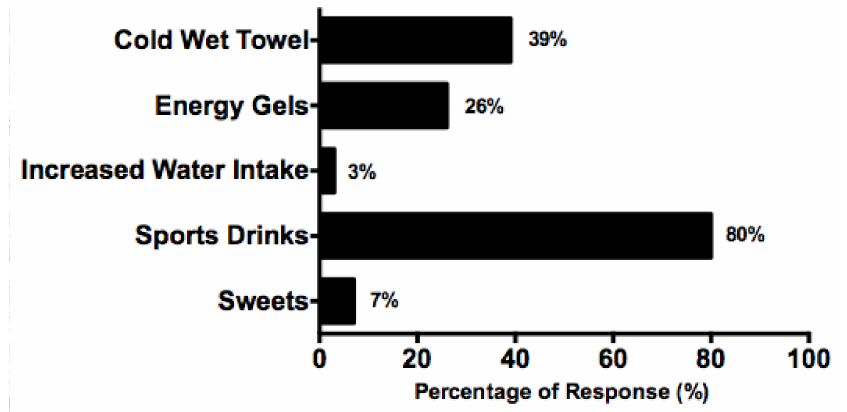
Figure 2. Considerations made by players during a long match (>2 h), expressed as a